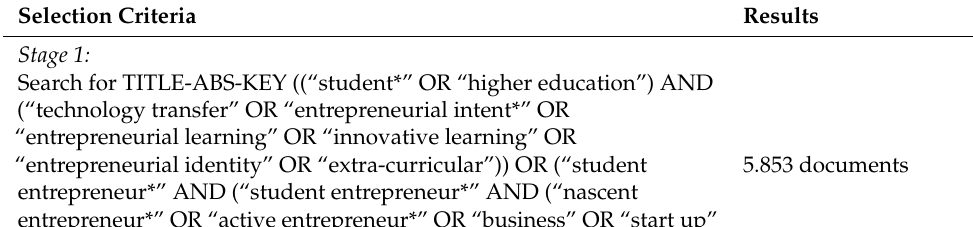
Table 1. Sample selection process.